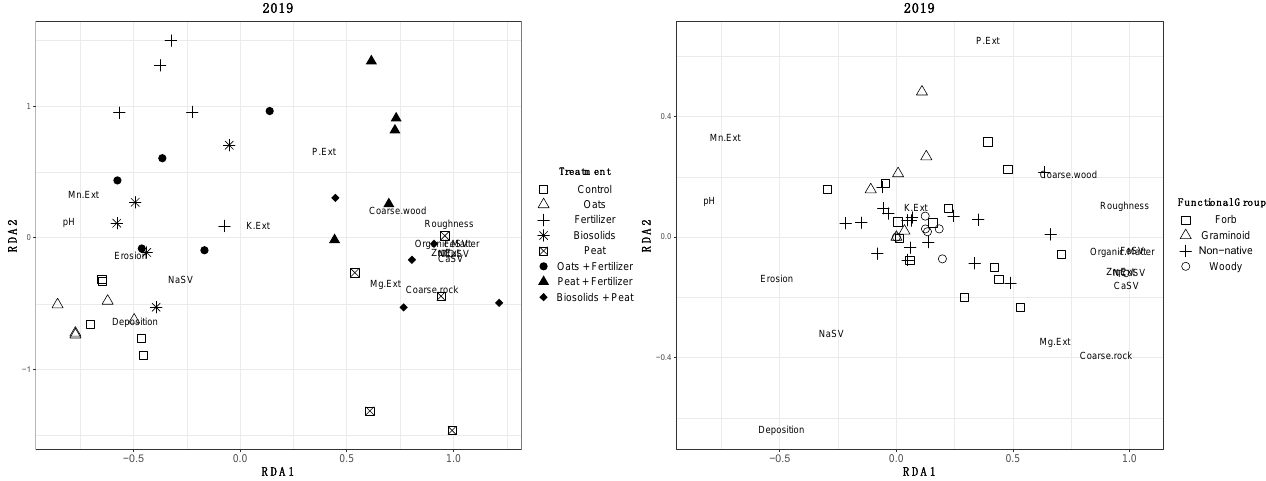
1 variance proportion explained = 0.434), whereas the greatest amount of the explained variance on the second axis is attributed to graminoids (2019; RDA 2 variance proportion Figure 4. Mean functional group alpha diversity by treatment and reference site. Within each year, treatments marked explained = 0.418) and forbs (2019; RDA 2 Variance proportion explained = 0.397). with different letters indicates a statistically significant difference ( p < 0.05).